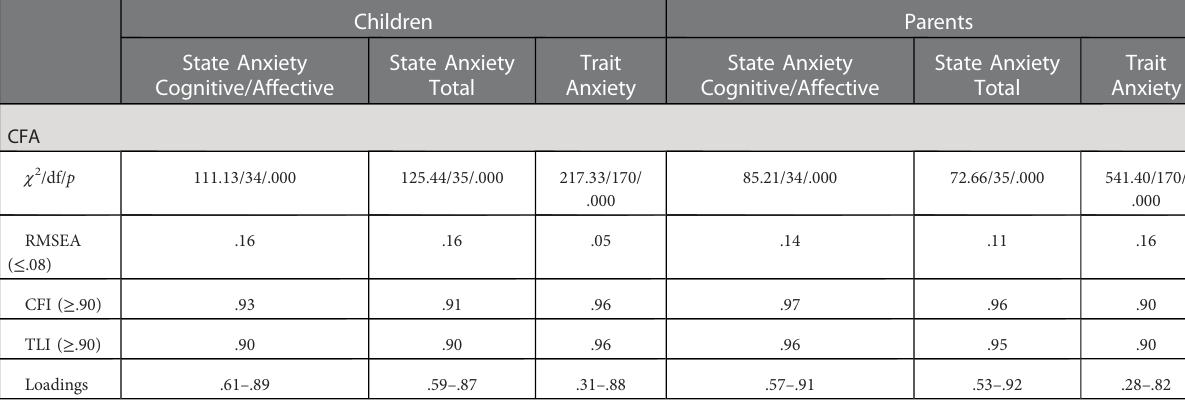
TABLE 3 Results of the con fi rmatory factor